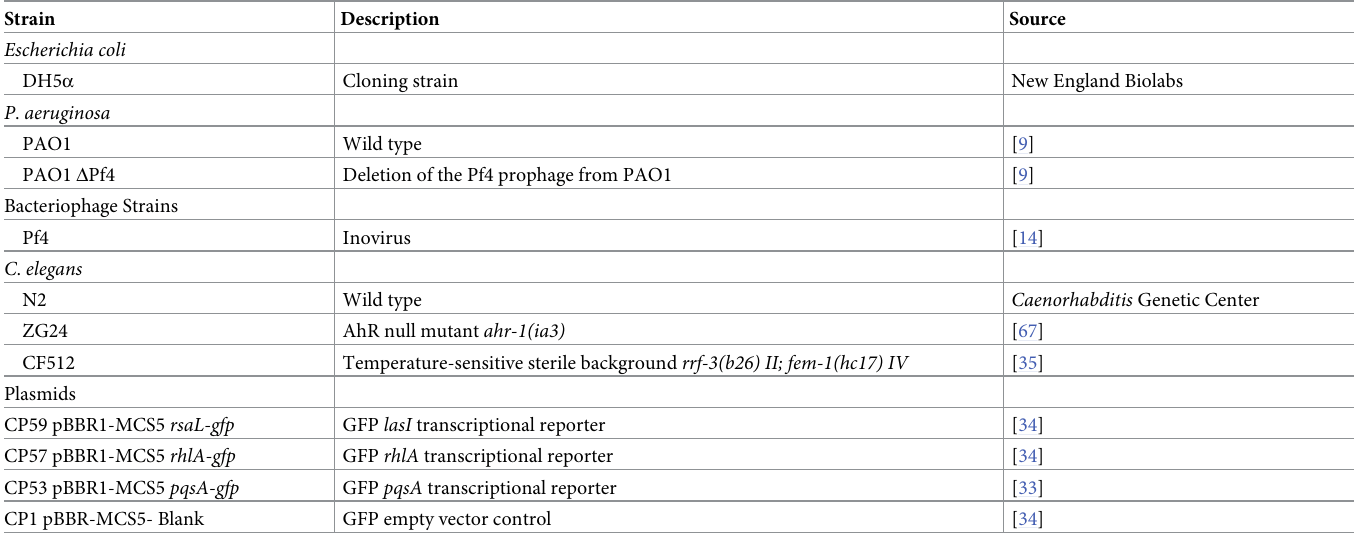
Table 1. Bacterial strains, phage, and plasmids used in this study.